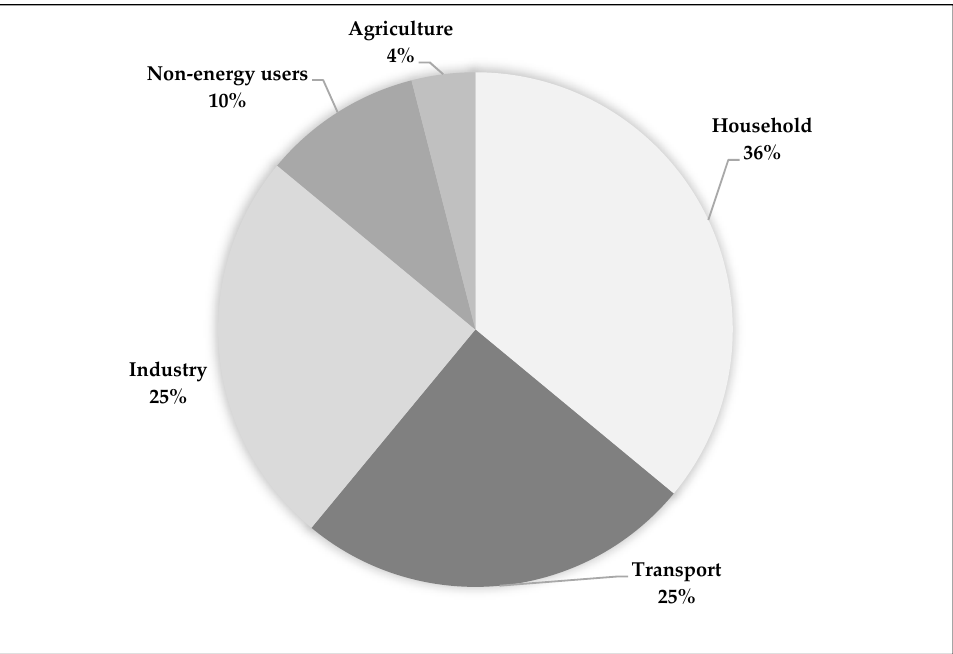
Figure 6. Distribution of energy consumption in different sections in Iran [115]. Reproduced with copyright, Elsevier.